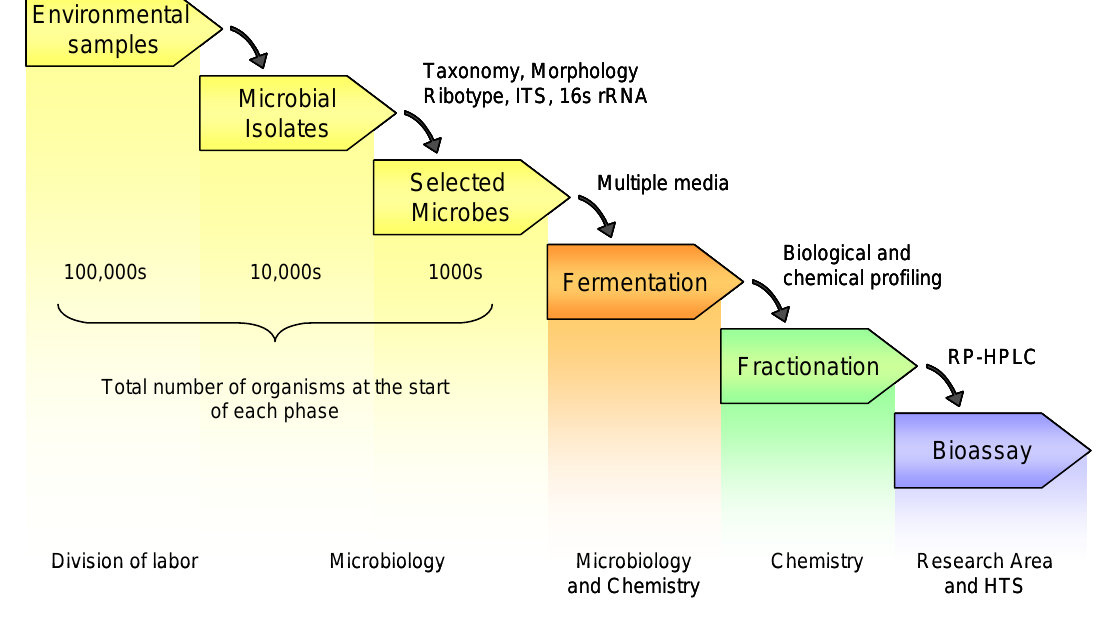
Figure 1. General schematic for library generation and